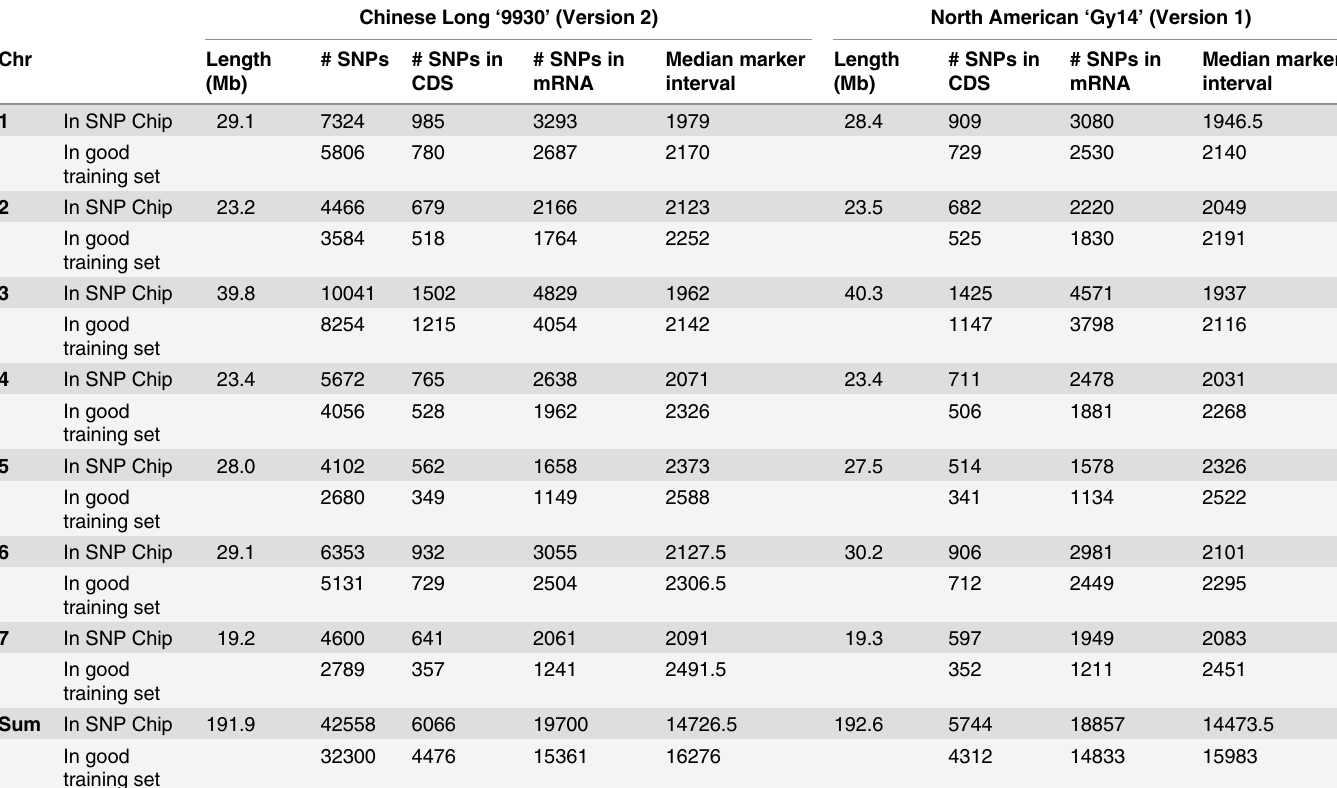
Table 1. Summary of marker properties on the array and in the 'good training set'